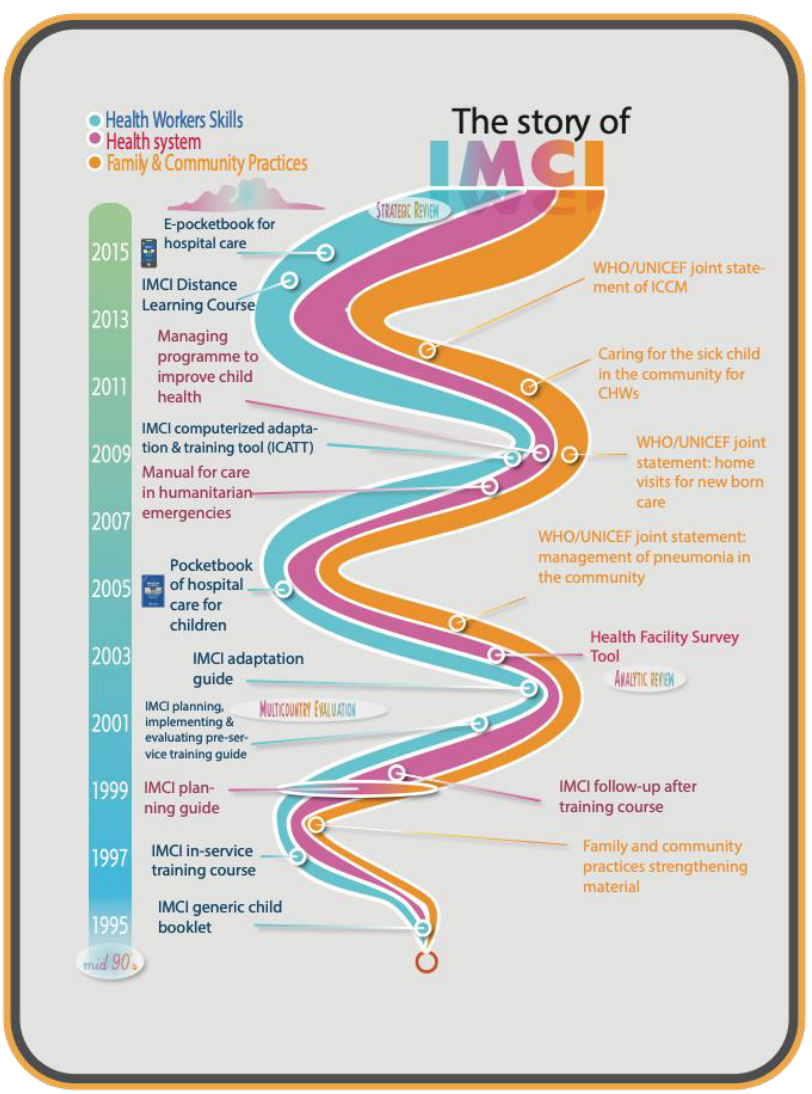
Figure 1. ‘The story of IMCI’. Reprinted from Integrated Management of Childhood Illness Global Survey Report , WHO, page 11, copyright 2017. Accessed 1 October 2018.